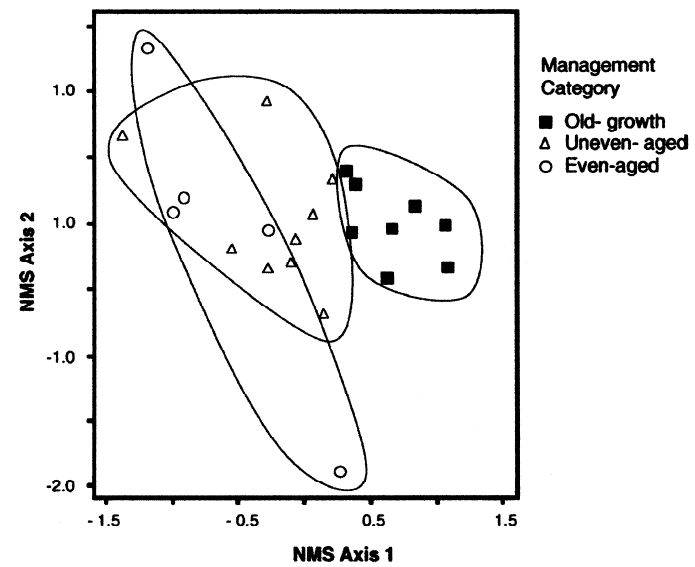
Figure 4. Nonmetric multidimensional scaling (NMS) ordination of carabid beetle diversity in old ‐ growth, uneven ‐ , and even ‐ aged eastern hardwood ‐ hemlock forests in northern Wisconsin and Upper Michigan, showing the association of study sites (stands) in species space. The separation of old ‐ growth (black squares) from the younger, managed forests indicates that old ‐ growth forests support a distinct carabid assemblage. From [4] with permission from Elsevier.